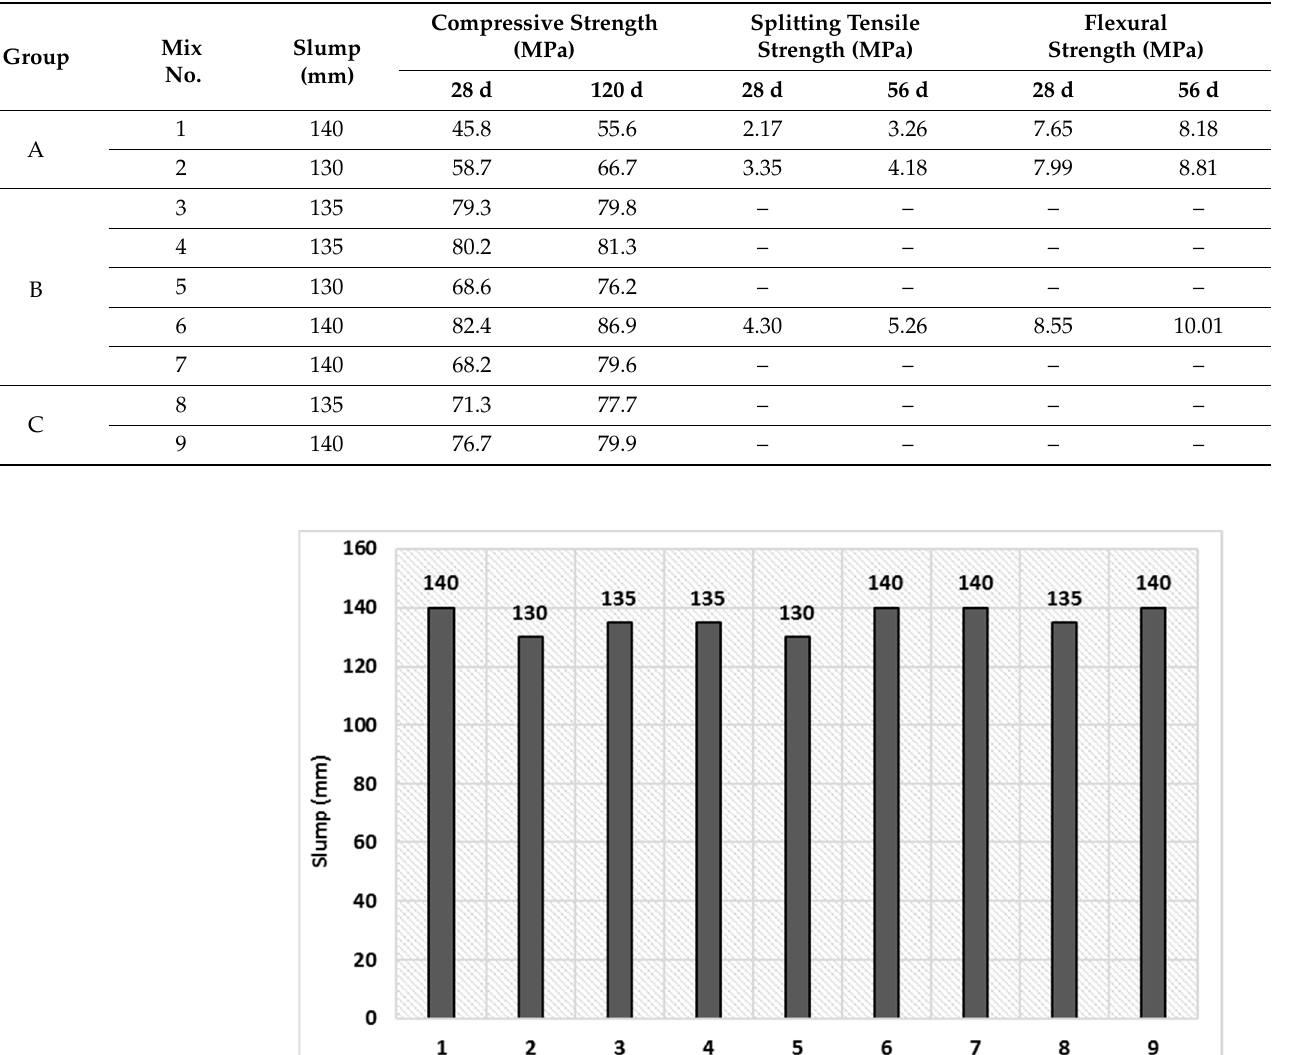
Table 5. Concrete mechanical characteristics test results.